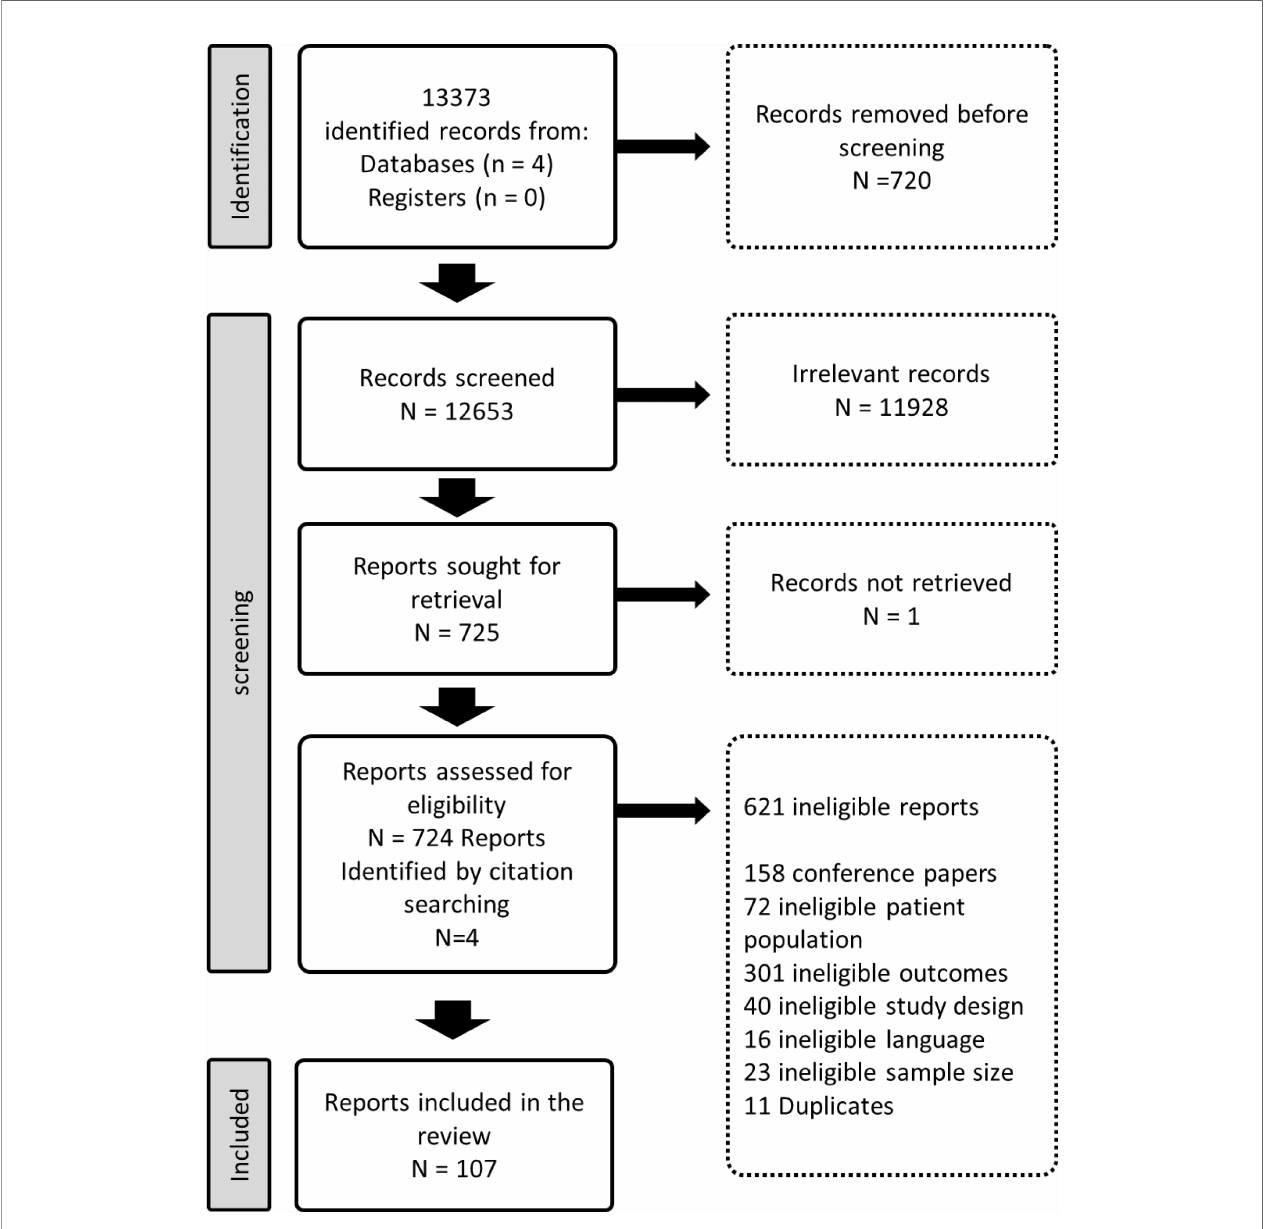
FIGURE 1 | PRISMA